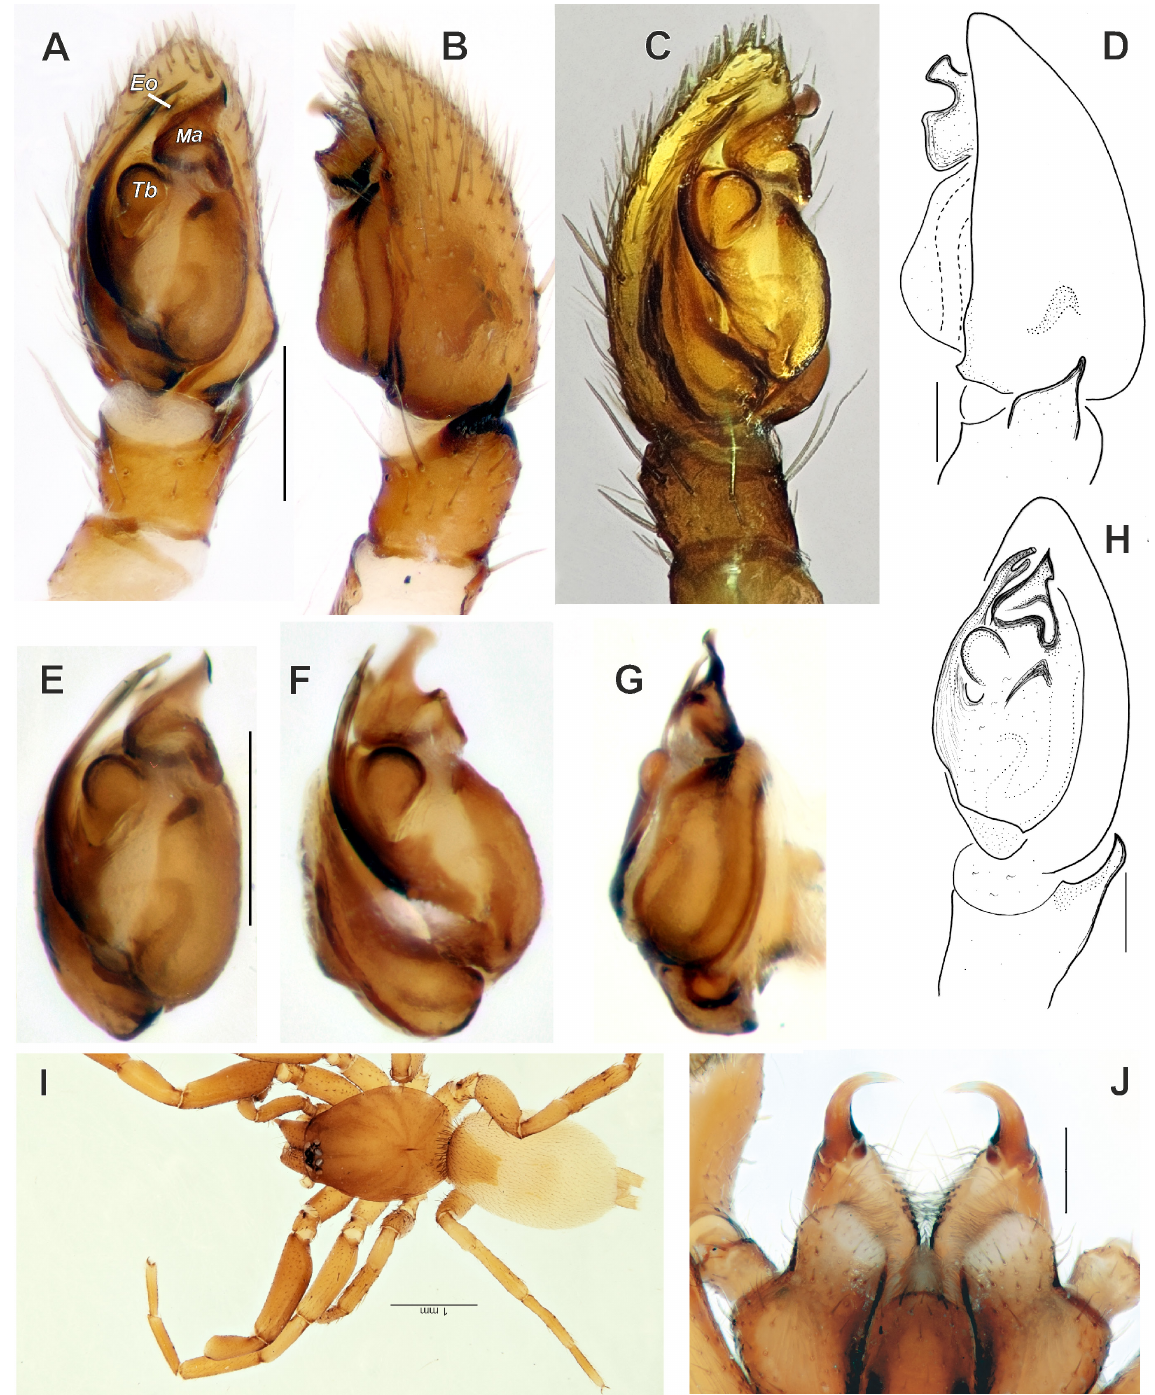
Fig. 7. Cryptodrassus iranicus sp. nov., holotype, ♂ (MHNG). A, C, H . Palp, ventral, proventral and retroventral views. B, D . Palp, retrolateral view. E–G . Bulb, ventral, proventral and retroventral views. I . Habitus, dorsal view. J . Chelicerae, posterior view. Abbreviations: Eo = embolar outgrowth; Ma = median apophysis; Tb = tegular bulge. Scale bars: A–B, E, J = 0.2 mm; D, H = 0.1 mm; I = 1